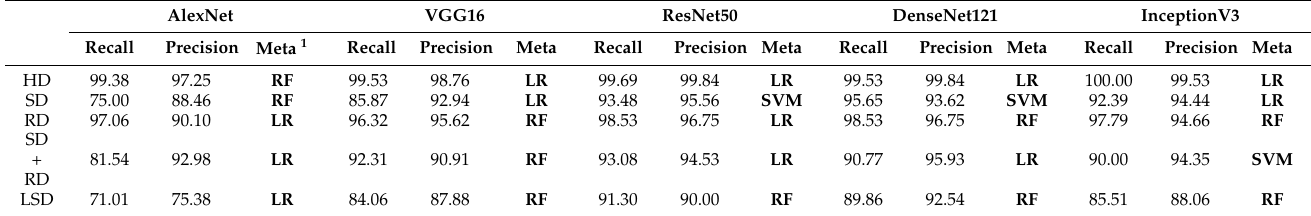
Table 5. Recall and precision of the best ensemble for each